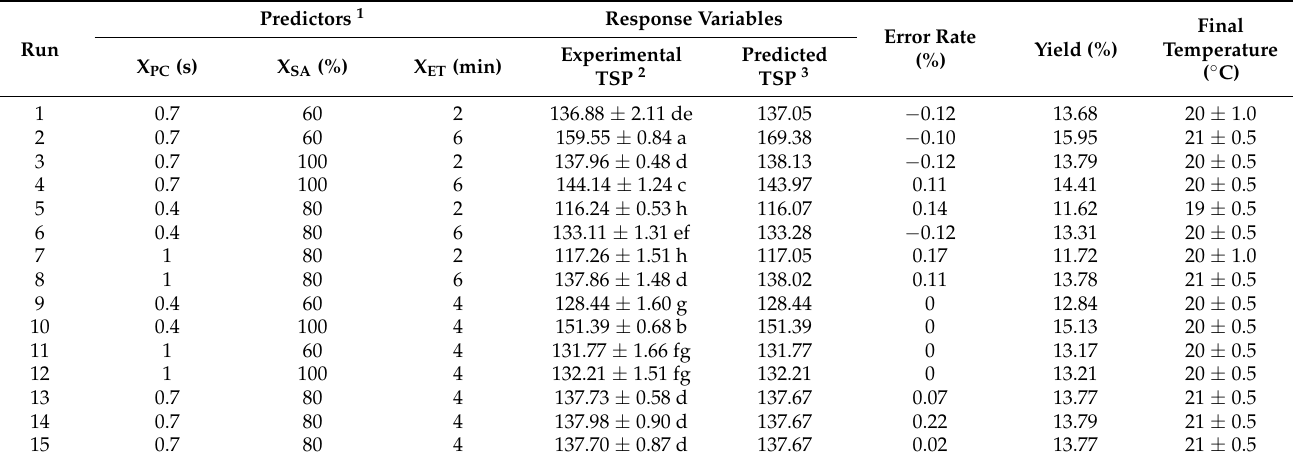
Table 1. Experimental matrix used for response surface methodology with experimental and pre- dicted values for the independent variables, error rate, yield, and final temperature after ultrasound- assisted extraction of Psidium cattleianum leaf